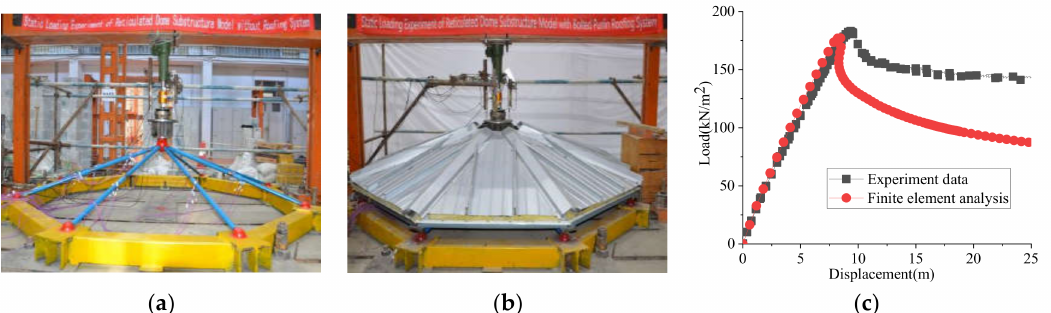
Figure 1. Experimental models of a simple reticulated shell structure with a roofing system: ( a ) the shell without roofing system; ( b ) the shell with roofing system; ( c ) comparison of experimental and simulation results.